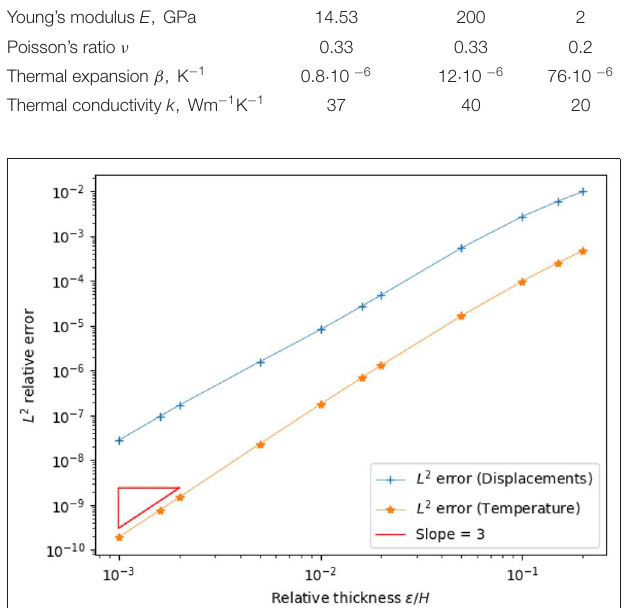
FIGURE 14 | Convergence with respect to the relative thickness ε/ h .